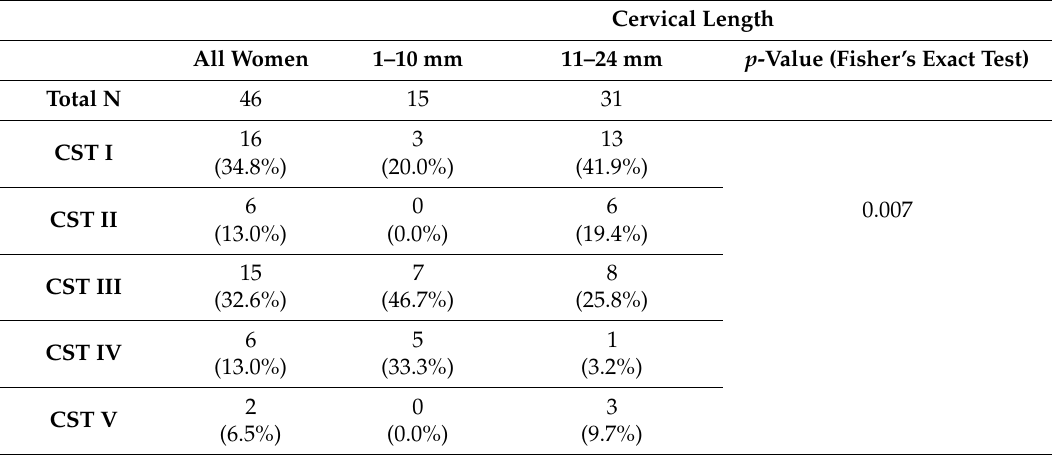
Table 2. Distribution of CSTs in all recruited women, according to cervical length. We differentiated the women with a very short cervix (1 – 10 mm) from the others (11 – 24 mm).